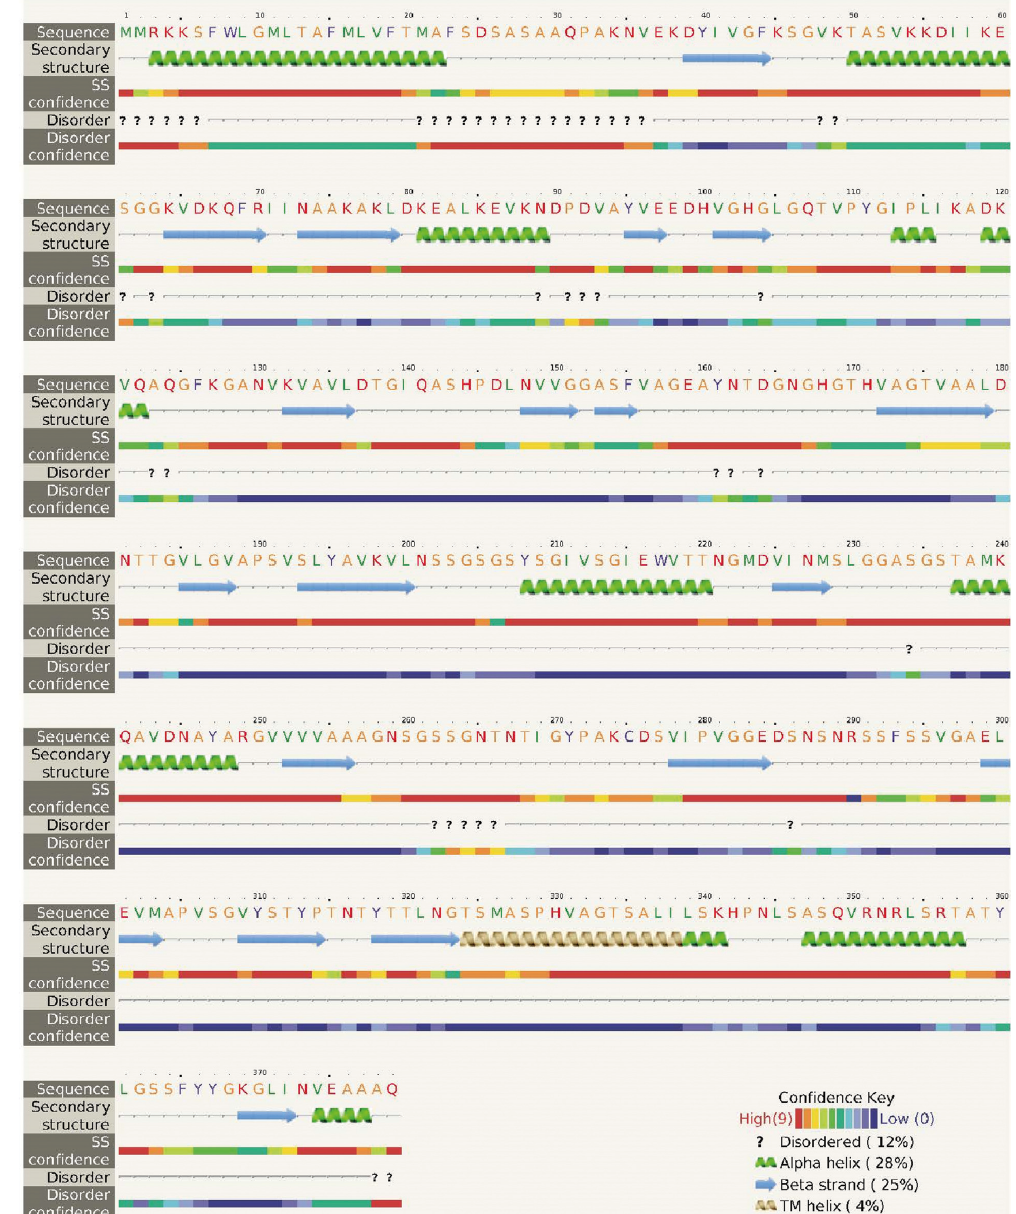
Figure 3: Secondary structure prediction of Bacillus subtilis by the Phyre2